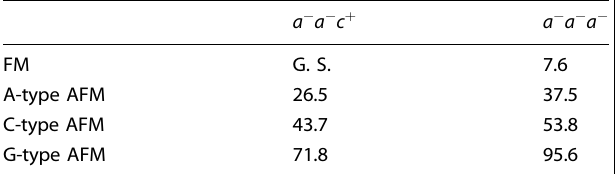
Table 1. Energy difference per formula unit relative to the ground state structure – i.e., the FM phase with the a − a − c + tilting system – of various magnetic orders and tilting systems. The energies are computed for the same in-plane lattice parameters, corresponding to 0% strain.